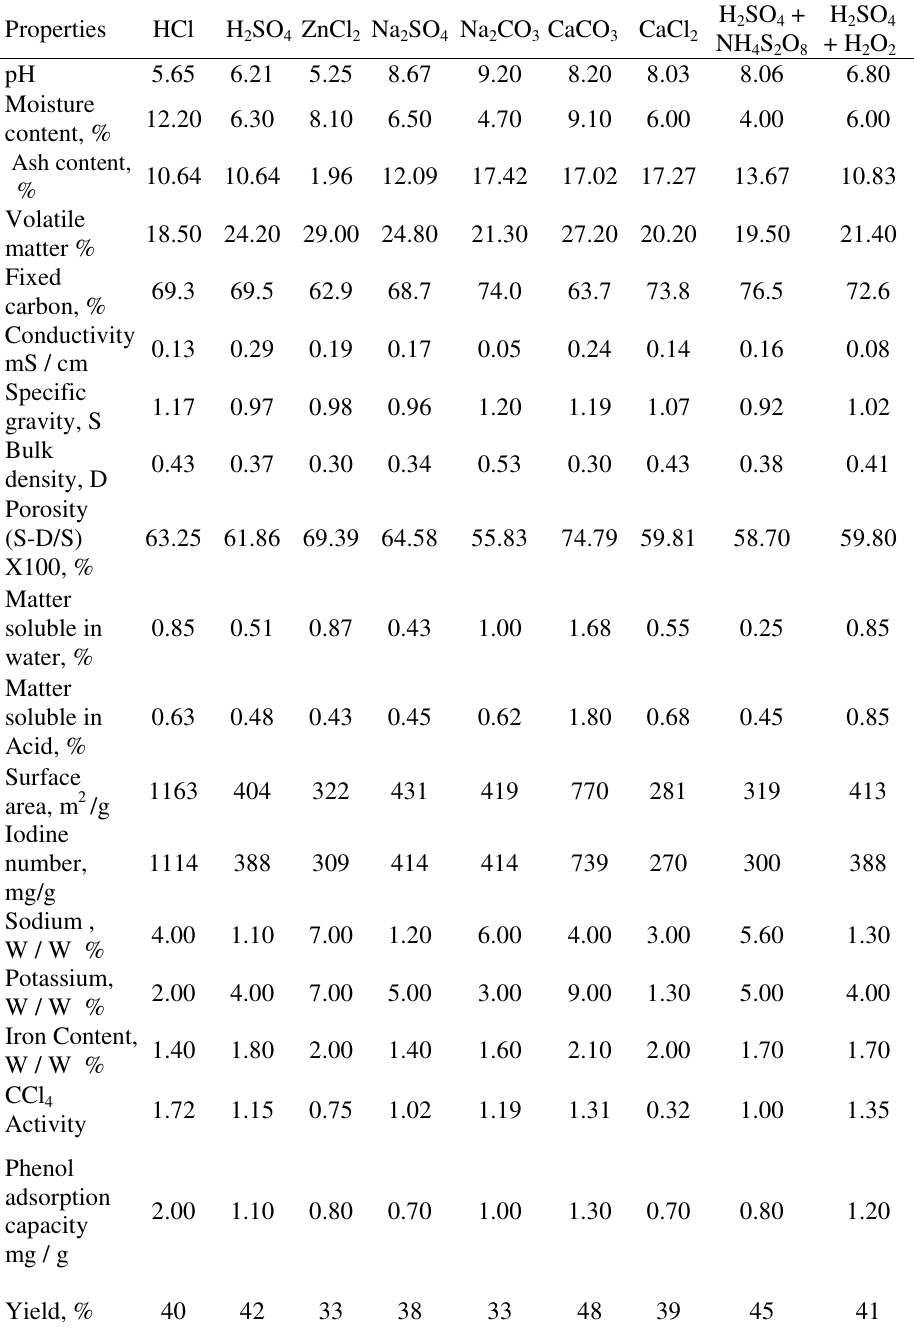
Table 3 Delonix regia seed shell waste activated carbon